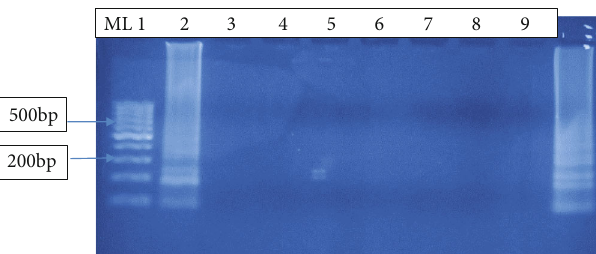
Figure 6: LAMP speci fi city testing on agarose gel electrophoresis. Lane ML is a molecular weight marker 100bp; lane 1: W. bancrofti DNA- positive specimen; lanes 2 – 7: non- W. bancrofti DNA of other parasites which did not show any ampli fi cation; lane 2: Brugia Malayi ; lane 3: Anopheles gambiae ; lane 4: S chistosoma mansion ; lane 5: Plasmodium falciparum ; lane 6: Trichuris trachura ; lane 7: Echinococcosis granulosus ; lane 8: negative control; lane 9: W. bancrofti DNA-positive control.